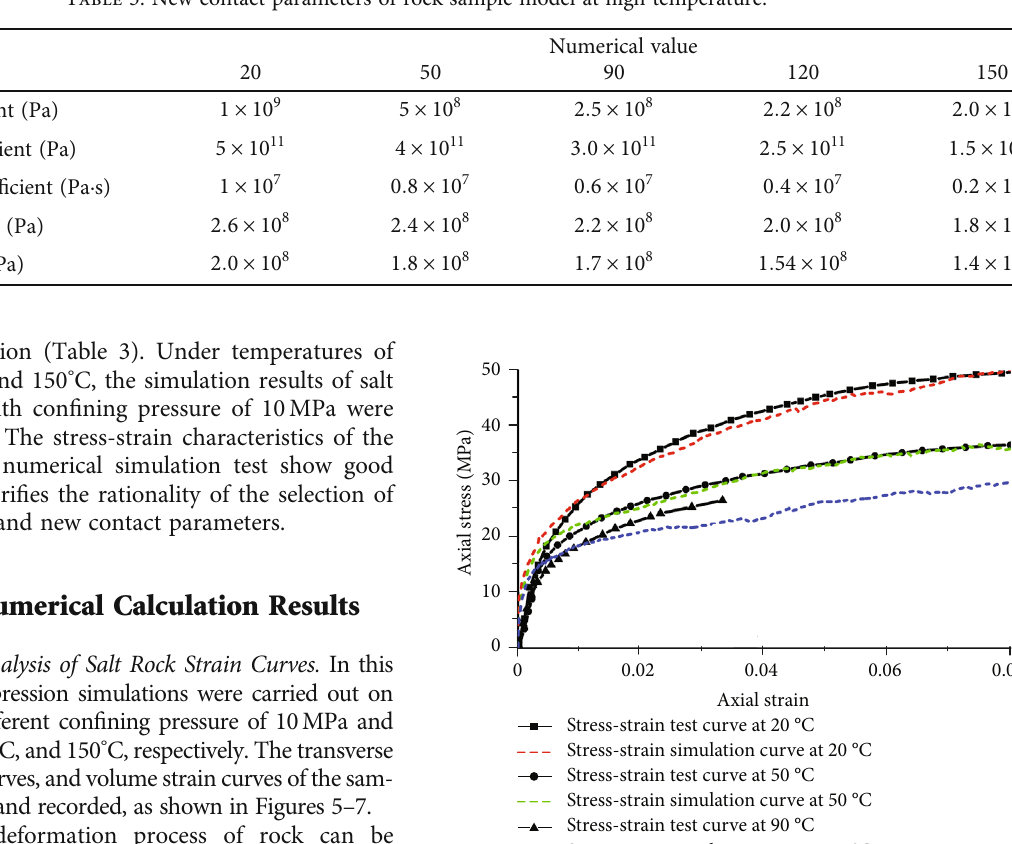
Table 3: New contact parameters of rock sample model at high temperature.